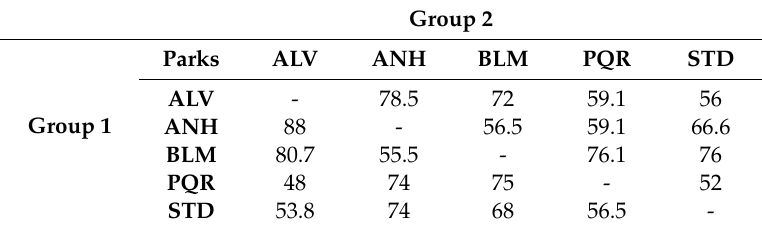
Table 4. Pairwise cross-validated classification scores (%) for Aedes scapularis populations. Group 2 Group 1